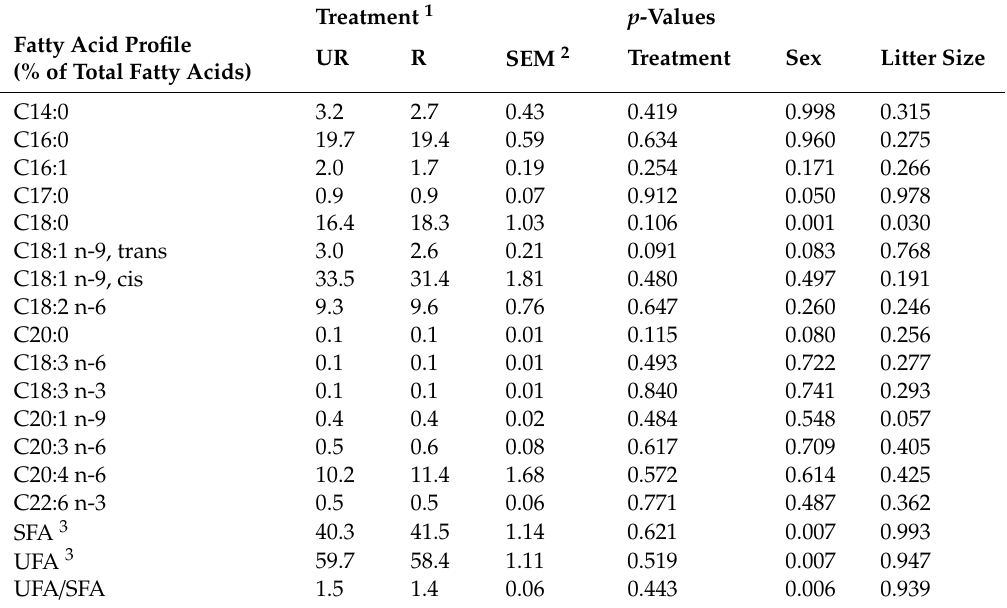
Table 6. E ff ects of maternal undernutrition during mid-gestation on the fatty acid profile in the Longissimus thoracis of the kids at 90 d of age.